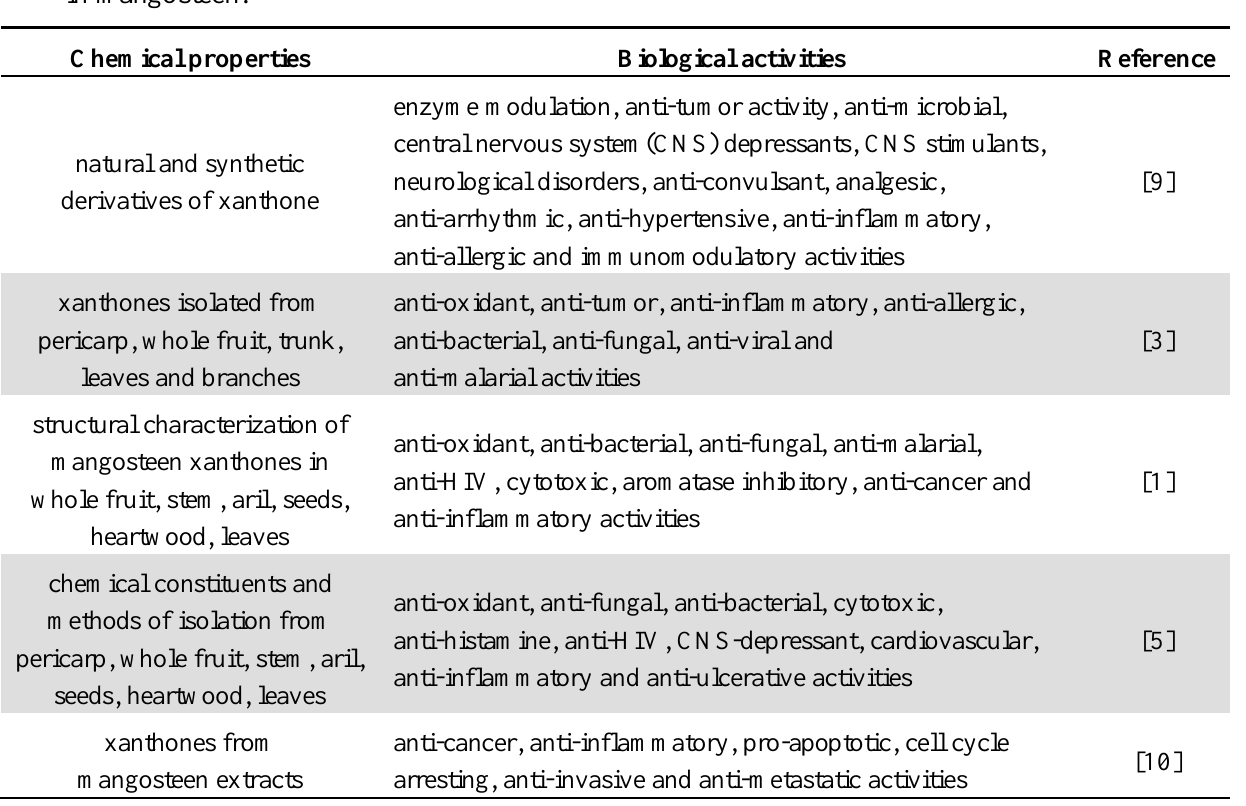
Table 1. Available reviews on chemical properties and bioactivities of xanthones in mangosteen.